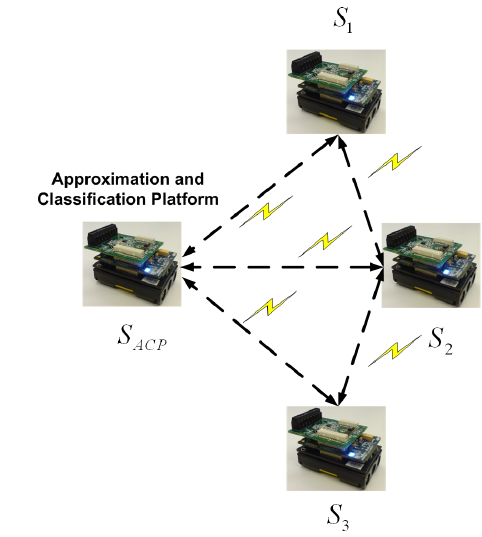
Figure 2. Architecture of the wireless sensor